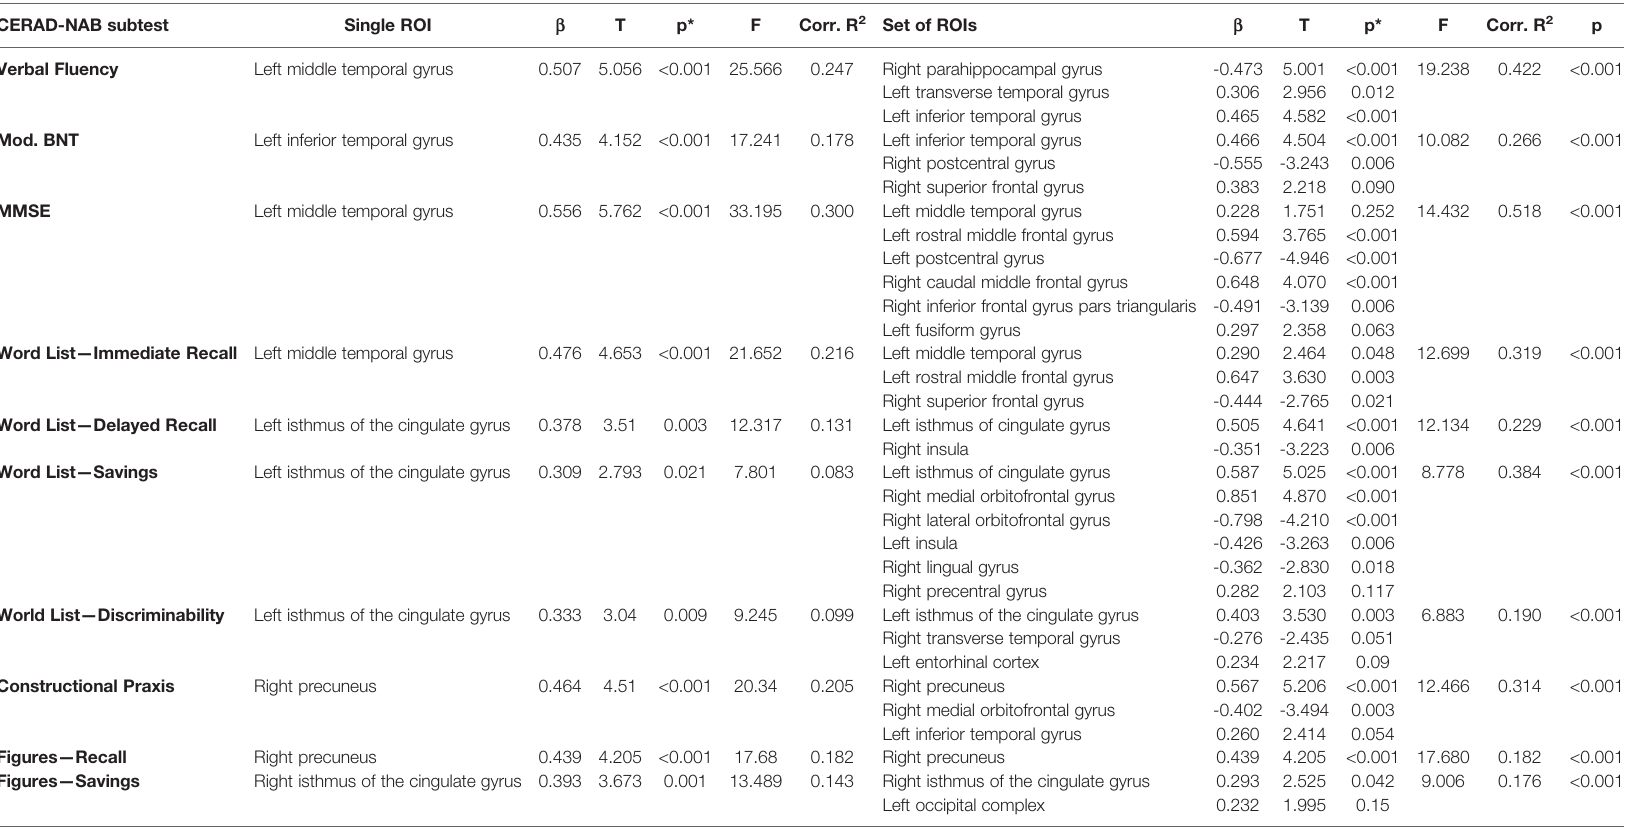
TABLE 3 | Relationship between cognitive performance and ROI-based glucose metabolism. CERAD-NAB subtest Verbal